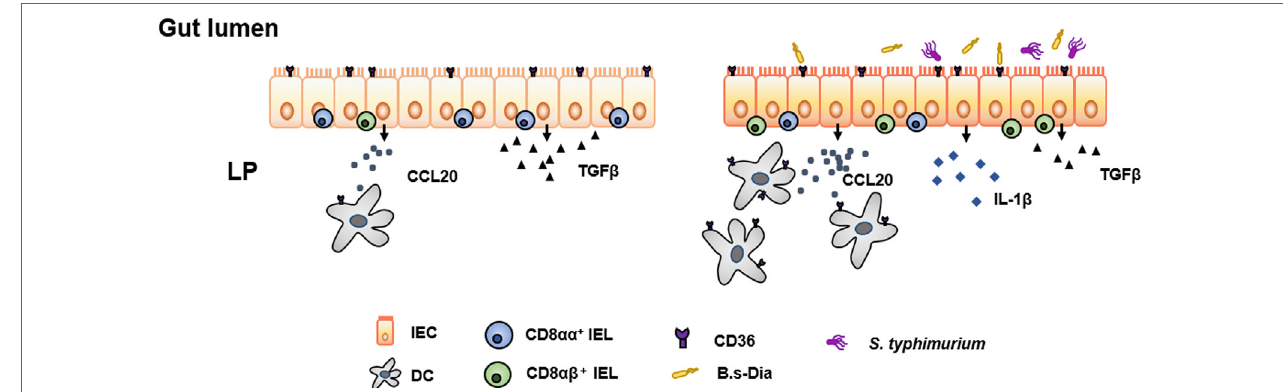
FigUre 6 | schematic representation of 4,4 ′ -diaponeurosporene-producing Bacillus subtilis (B.s-Dia)-induced immunopotentiation . B.s-Dia could “activate” intestinal epithelial cells (IECs) in a CD36-dependent manner. Compared with “unactivated” IECs (left panel), B.s-Dia activated IECs (right panel) upregulated the production of CCL20, recruiting more dendritic cells (DCs), and downregulated the production of TGF β , which might be responsible for the decrease of CD8 αα + intraepithelial lymphocytes (IELs). When Salmonella typhimurium infected, activated IECs could rapidly respond and upregulated the production of IL-1 β . These multiple outcomes of intragastric administration of B.s-Dia increased host defenses against S. typhimurium